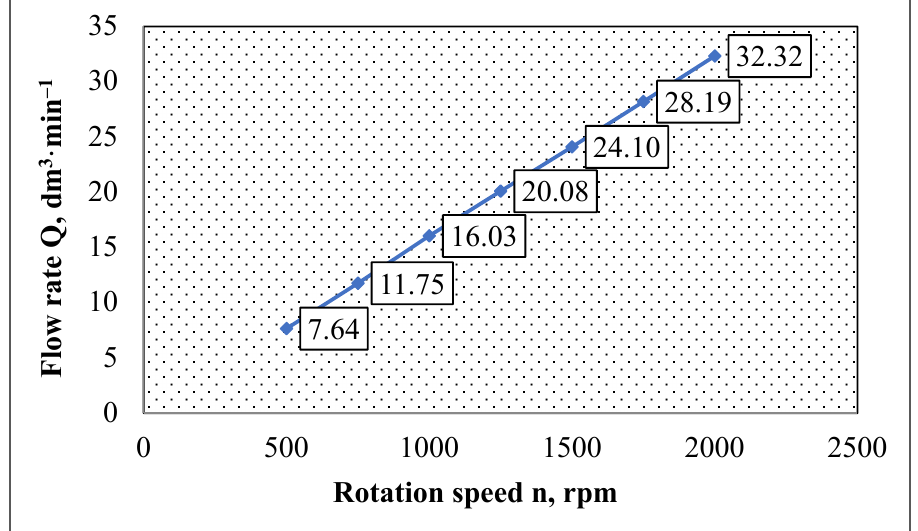
Figure 9. Flow characteristics of the transducers in the primary circuit. Table 9. Basic statistical evaluation, verification of flow characteristics of transducers in the second- ary circuit.